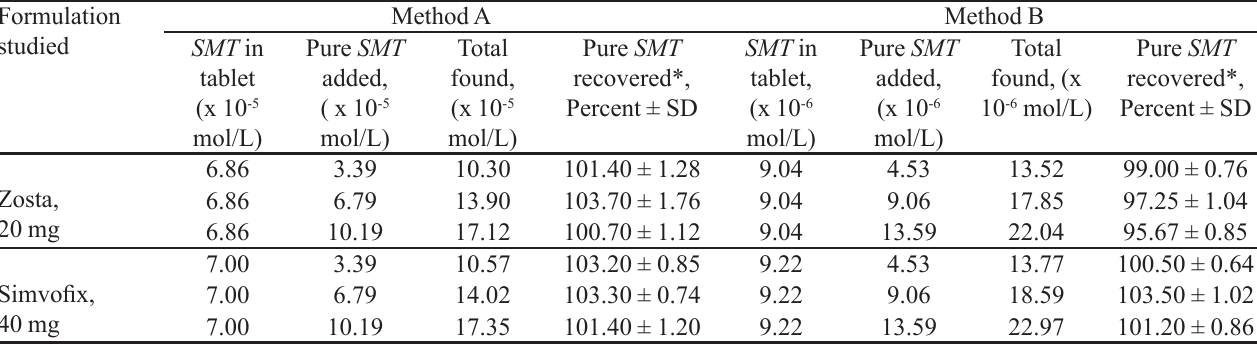
TABLE IV - Results of recovery study by standard addition method Formulation studied